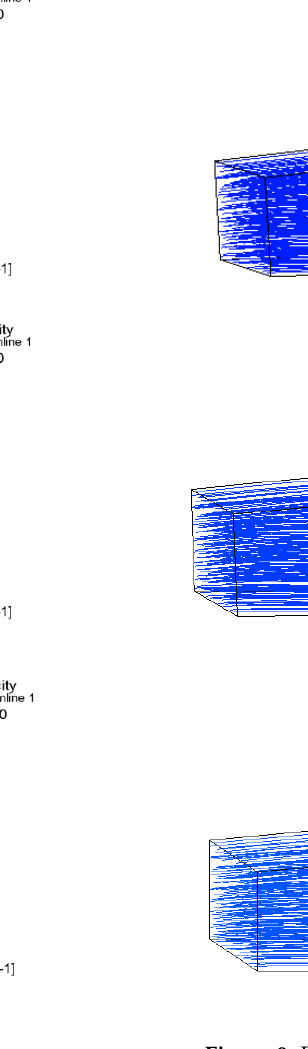
Figure 9. Flow diagrams of the full flow channel under different working conditions.